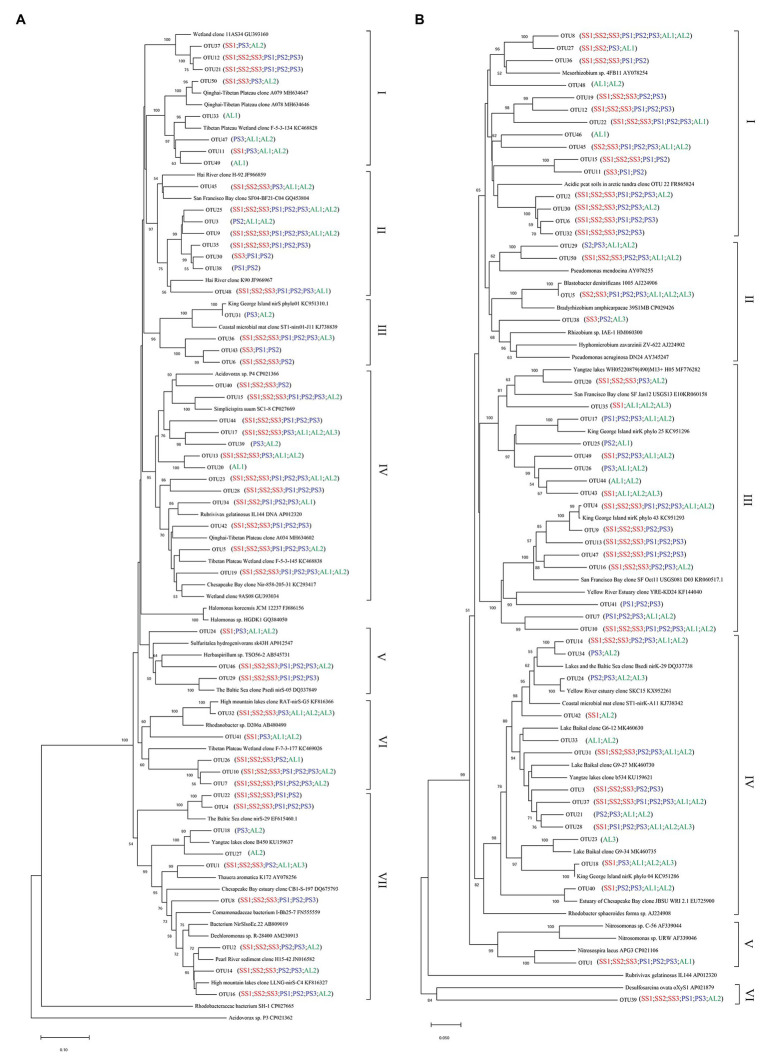
Neighbor-joining phylogenetic tree of nirS (A) and nirK (B) sequences in tundra soils of maritime Antarctica. Bootstrap values ≥ 50% (n = 1,000) are shown near the nodes. Operational taxonomic units (OTUs) were defined at 97% similarity.